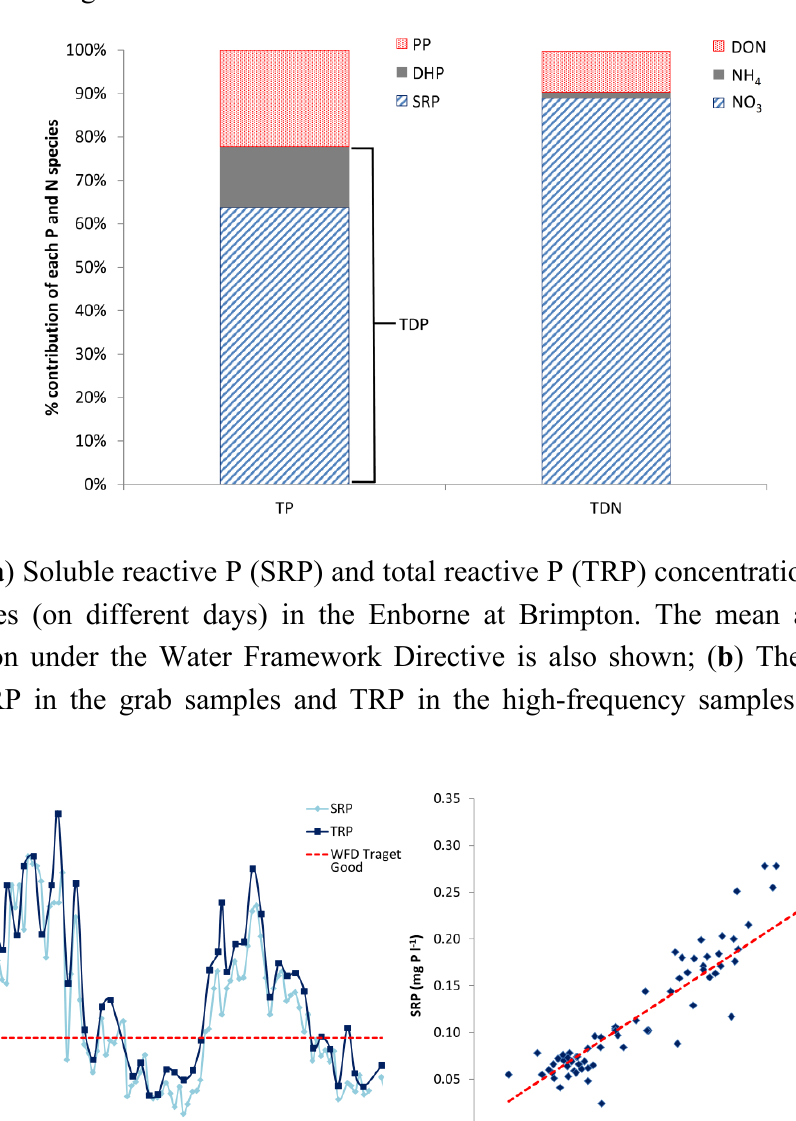
Figure 5. Mean annual percentages of different P and N species in the Enborne. SRP, soluble reactive P; DHP, dissolved hydrolysable P; PP, particulate P; TDP, total dissolved P; DON, dissolved organic N.